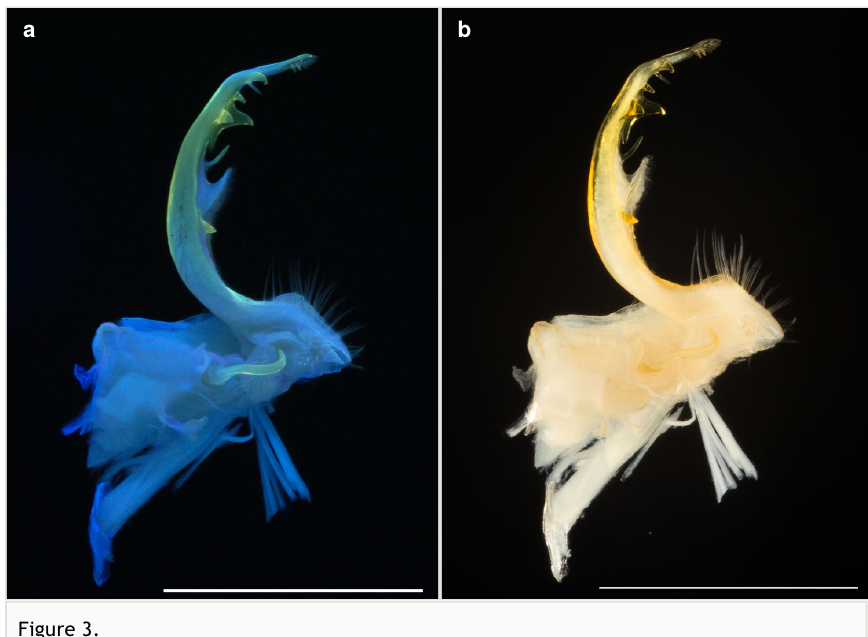
Figure 3. The left gonopod of a male Pseudopolydesmus canadensis imaged in 350 nm UV light from a Canon 199A modi fi ed fl ash and incident visible (white) light. Scale bars = 1 mm. a : 350 nm UV light from a Canon 199A modi fi ed fl ash b : Incident visible (white) Brachoria sheari , Xystodesmidae (Fig. 4a). (Image of the gonopod.) Variable fl uorescence in blue and yellow-green. Prostatic sperm groove visible on the acropodite leading to the apex. The species possesses a more robust gonopod than P. canadensis and some